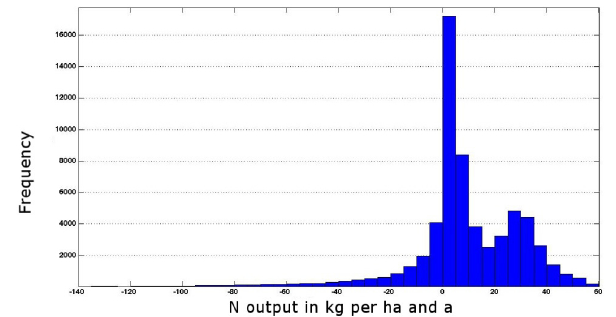
Fig. 4. Histogram of the frequency distribution of excess Nitrogen (kgNha − 1 a − 1 ) of the HRUs.